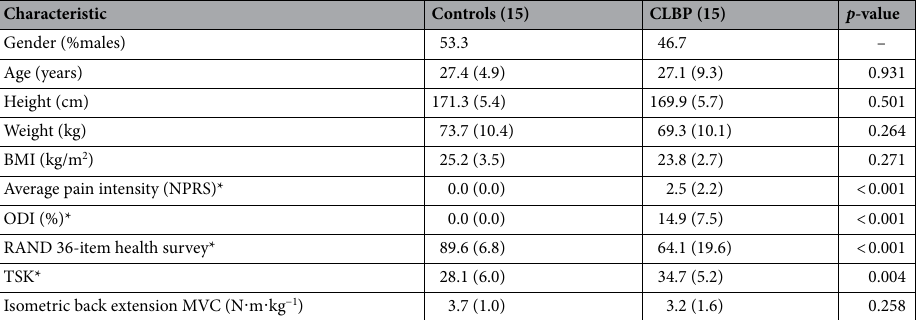
Table 1. Characteristics of all participants separated by group. Data are presented as mean ± SD. CLBP chronic low back pain. BMI body mass index. NPRS numerical pain rating scale. ODI Oswestry Disability Index. RAND Research and Development. TSK Tampa Scale for Kinesiophobia. MVC maximal voluntary contraction. The asterisk (*) indicates statistically significant differences between